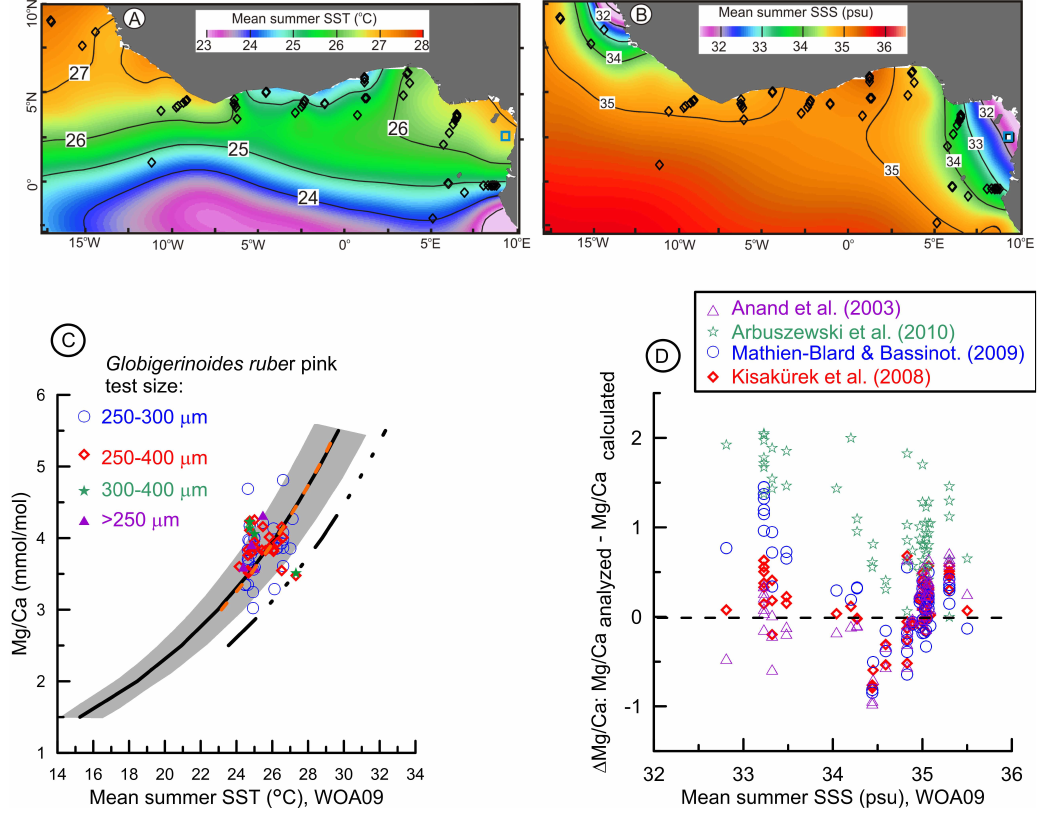
Fig. 2. Mean summer SST (a) and SSS (b) in the Gulf of Guinea (Locarnini et al., 2010; Antonov et al., 2010) plotted using Ocean Data View (Schlitzer, 2012). Black diamonds and a blue square indicate locations of core top sampling and MD03-2707, respectively. (c) Mg/Ca analyzed in G. ruber (pink) from core top samples plotted versus mean summer SST (Locarnini et al., 2010). Solid line (Mg/Ca=0.38 × exp(0.09 × T )) and grey area indicate the global calibration curve and its area of uncertainty, respectively (Anand et al., 2003; Dekens et al., 2002). Orange (Mg/Ca=0.34 × exp(0.09 × T )) and black (Mg/Ca=0.30 × exp(0.089 × T )) dashed lines indicate cali- bration curves for G. ruber white established by McConnel and Thunnell (2005) and Lea et al. (2000), respectively. (d) Difference in Mg/Ca ( 1 Mg/Ca) between analyzed core top and calculated values plotted versus mean summer SSS (Antonov et al., 2010). Calculated Mg/Ca val- ues are obtained using Mg/Ca-SST-SSS (Arbuszewski et al., 2010; Kisak¨urek et al., 2008; Mathien-Blard and Bassinot, 2009) and Mg/C-SST equations (Anand et al.,